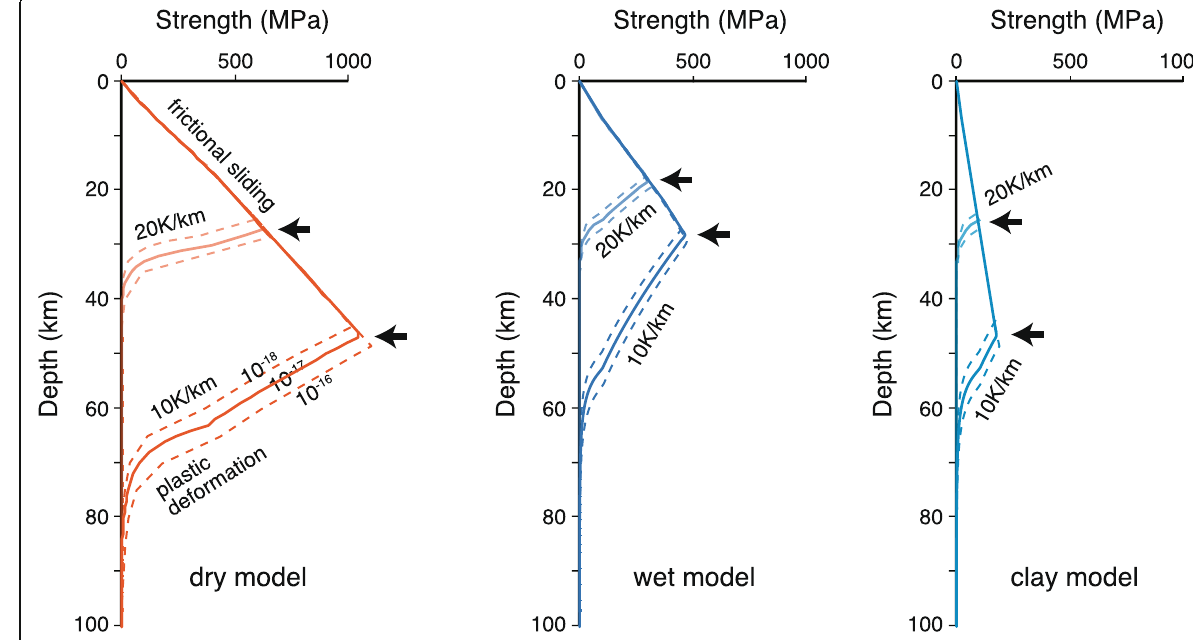
Fig. 2 Strength models for Earth calculated using a constant strain rate of 10 − 17 s − 1 (solid lines) with variation in strain rates between 10 − 16 and 10 − 18 s − 1 (dashed lines). The strength of shallow parts is controlled mainly by frictional sliding and that of deeper parts by plastic deformation. Arrows indicate the transition from brittle to ductile deformation for each model. An increasing thermal gradient results in a decrease in plastic strength at depth and a shallower brittle – ductile transition. Water reduces the strength of both the brittle and ductile regions; consequently, lithospheric strength is markedly lower under wet conditions compared with dry. The presence of clay results in the markedly low frictional coefficient, and hence further decreases the brittle